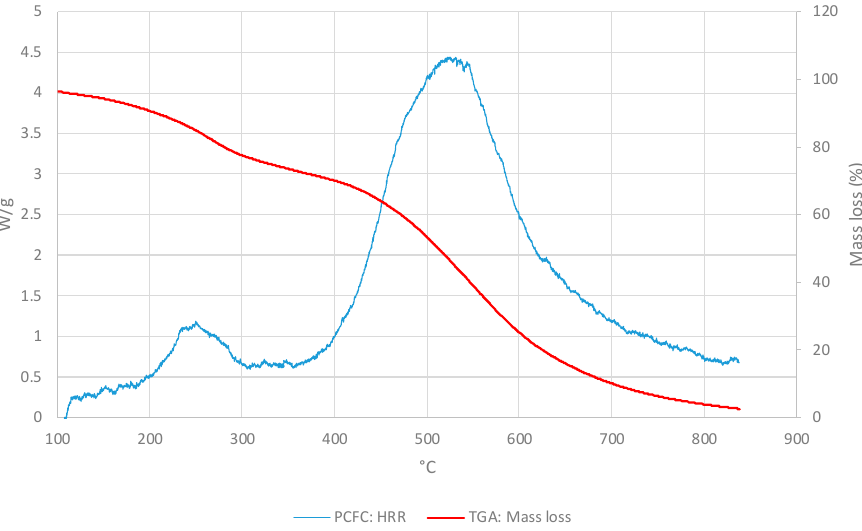
Polymers 2019 , 11 , x FOR PEER REVIEW Figure 7. Values of HRRs (W / g) and of mass loss (wt.%) for the OSM layer. Figure 7. Values of HRRs (W/g) and of mass loss (wt.%) for the OSM layer.